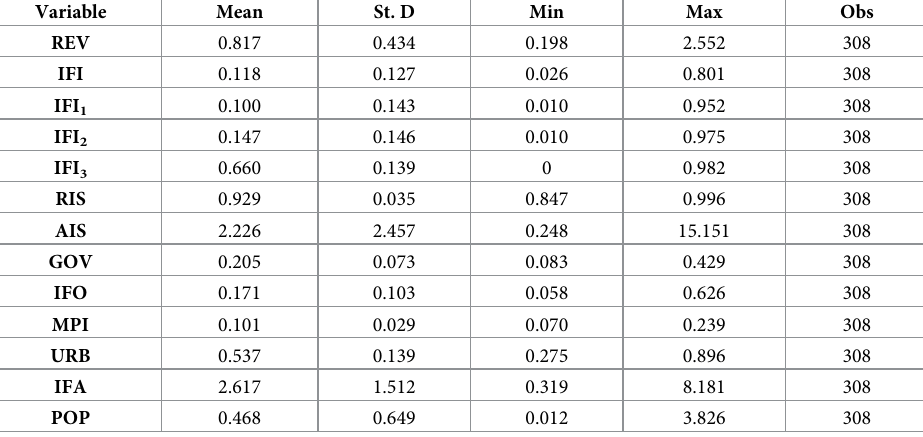
Table 3. Sample descriptive